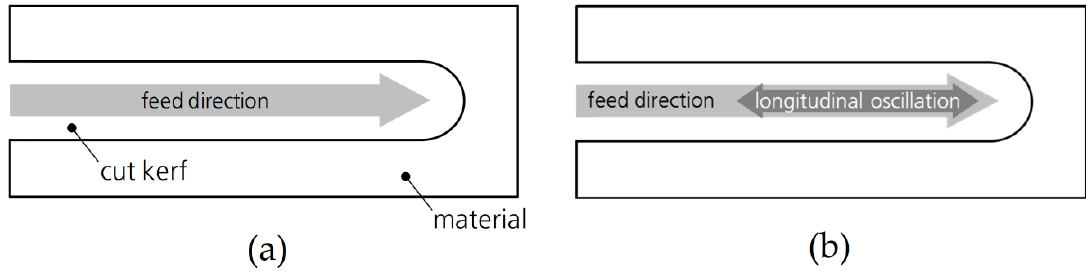
Figure 1. Schematic beam movement of ( a ) Static beam shaping; ( b ) Longitudinal, linear beam oscillation.